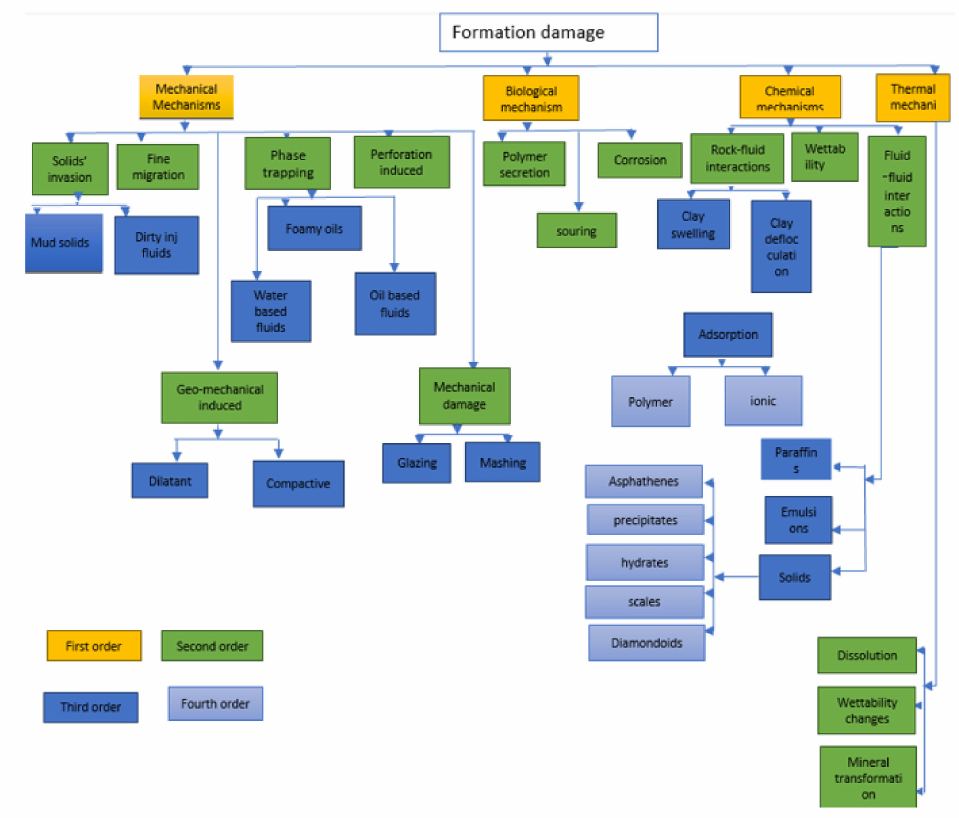
Figure 2. Category of formation damage mechanisms in sandstone, adapted from